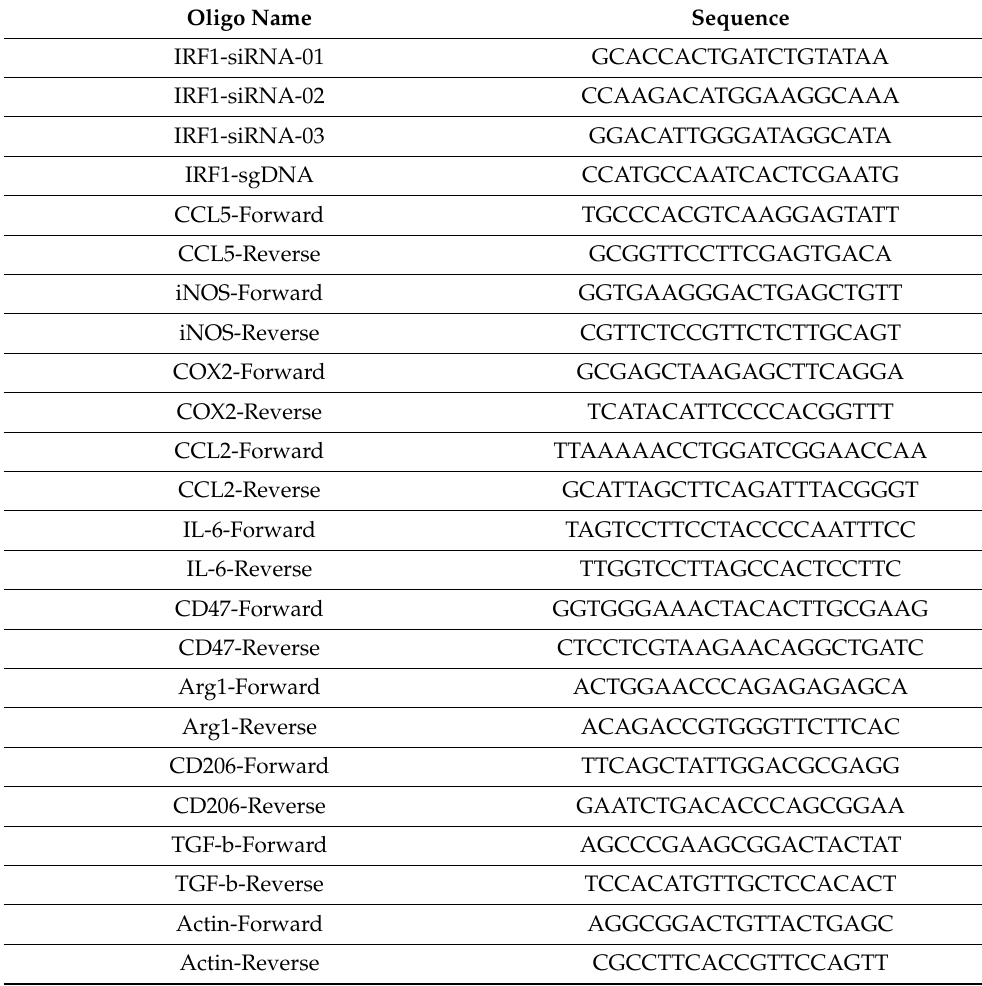
Table 2. Nucleotide sequence. Oligo Name